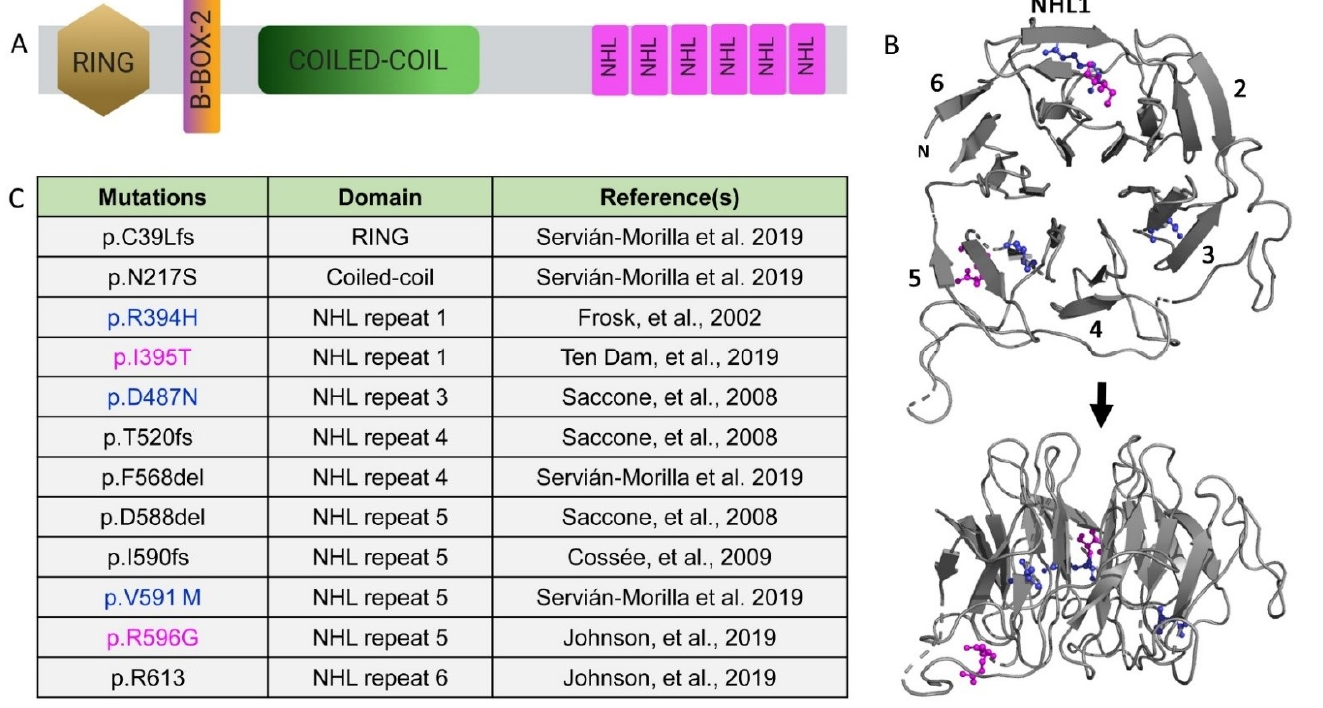
Figure 2. Limb-girdle muscular dystrophy type 2H (LGMD2H)-causing TRIM32 mutations in the NHL domains. ( A ) Schematic of the TRIM32 protein. ( B ) Ribbon diagram showing the face (top panel) and 90° rotation (bottom panel) of human NHL domains. Colored amino acids are listed in panel B. ( C ) Table illustrating mutations causative for LGMD2H. Known point mutations are in color, with blue representing amino acids strictly conserved in the Drosophila TRIM32 sequence.